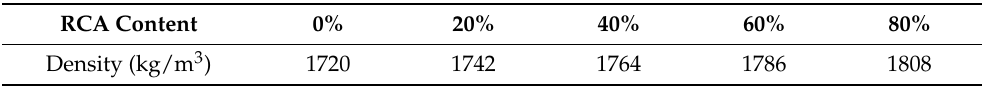
Figure 2. Large-scale direct shear apparatus. Table 1. Densities of samples with different RCA